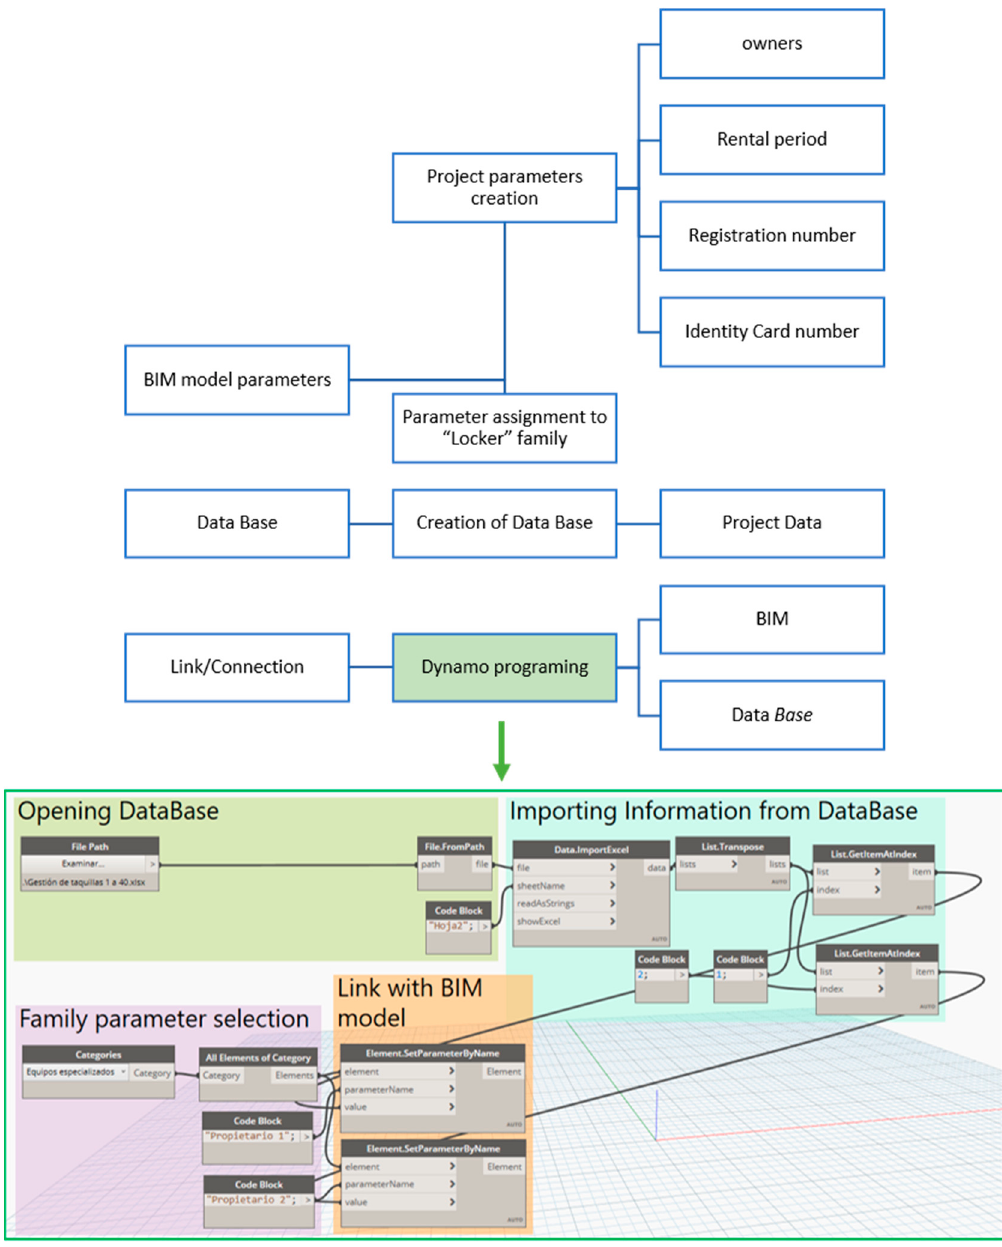
Figure 13. Dynamo lockers parameters programming.